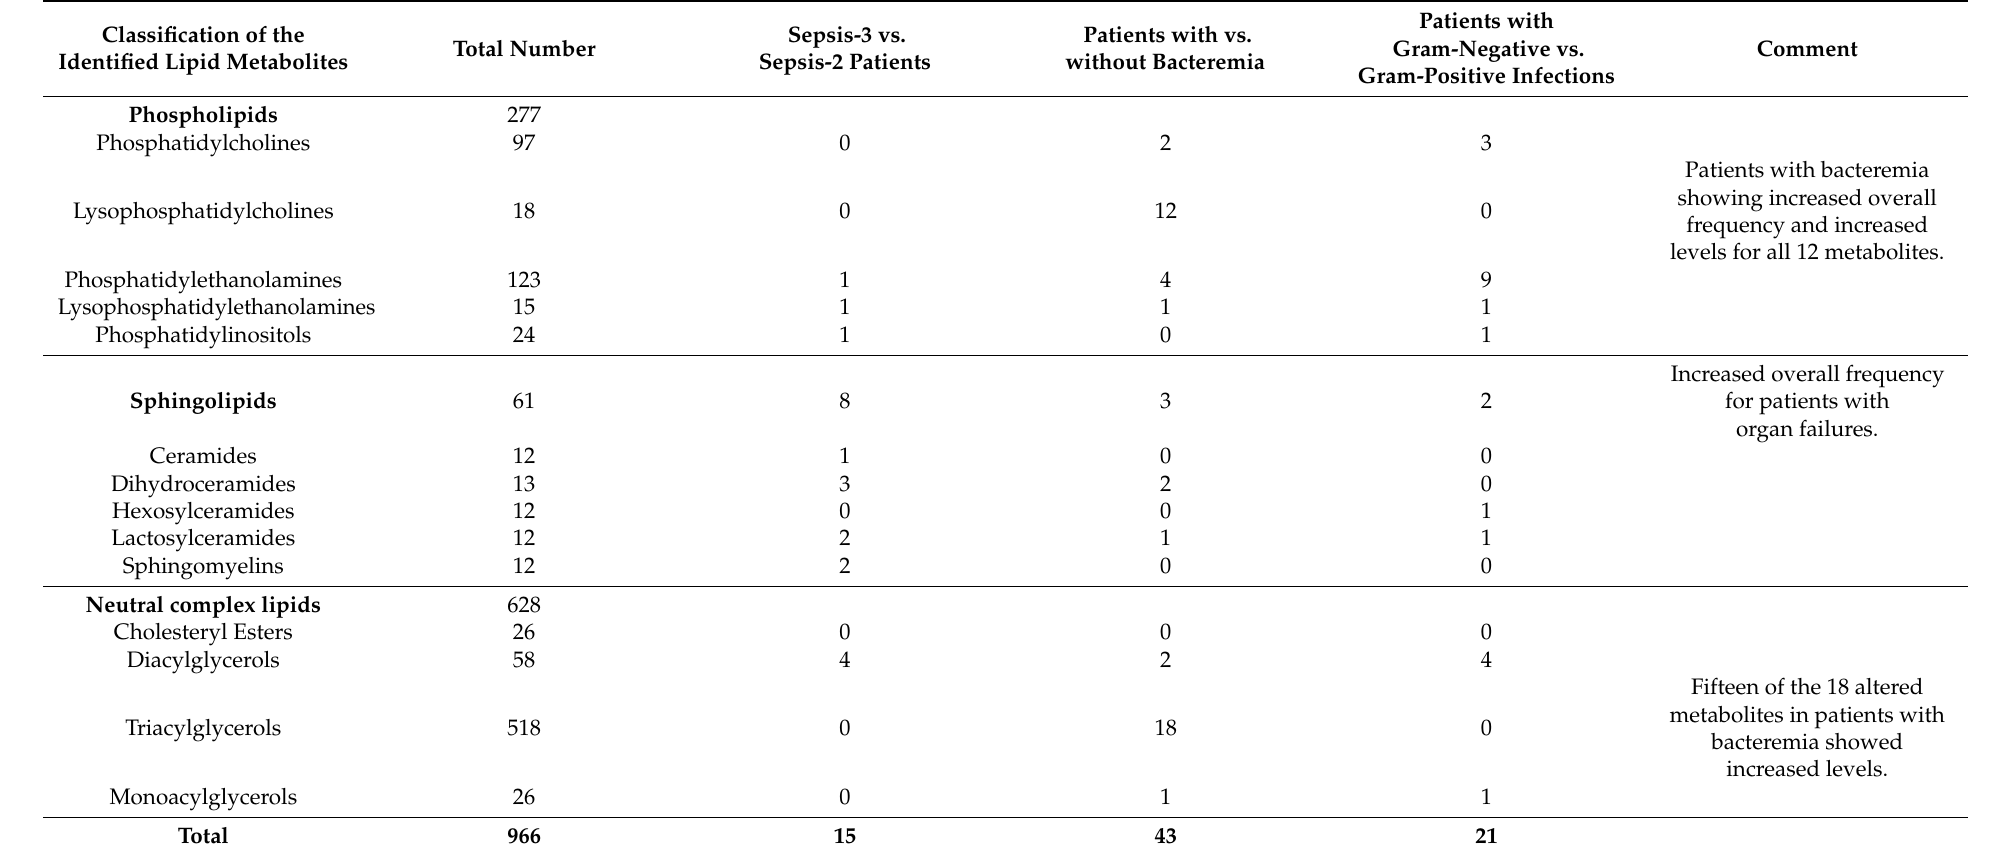
Table 2. Lipidomic profiles in patients with bacterial sepsis; a summary of the overall results for all 60 patients and the 966 lipid biochemicals identified in the present study. The table presents the classification of various lipid metabolites, the total numbers of identified metabolites for each of the three main classes (written in bold) and their subclasses (Total number), number of differing metabolites when comparing patients with and without organ failure (i.e., Sepsis-3 vs. Sepsis-2 patients), patients with/without bacteremia and the comparison of patients with Gram-positive versus Gram-negative bacterial infections. The study included 60 patients (30 with Gram-positive and 30 with Gram-negative infections); 35 patients fulfilled the Sepsis-3 definition and 30 patients had bacteremia (14 with Gram-positive and 16 with Gram-negative